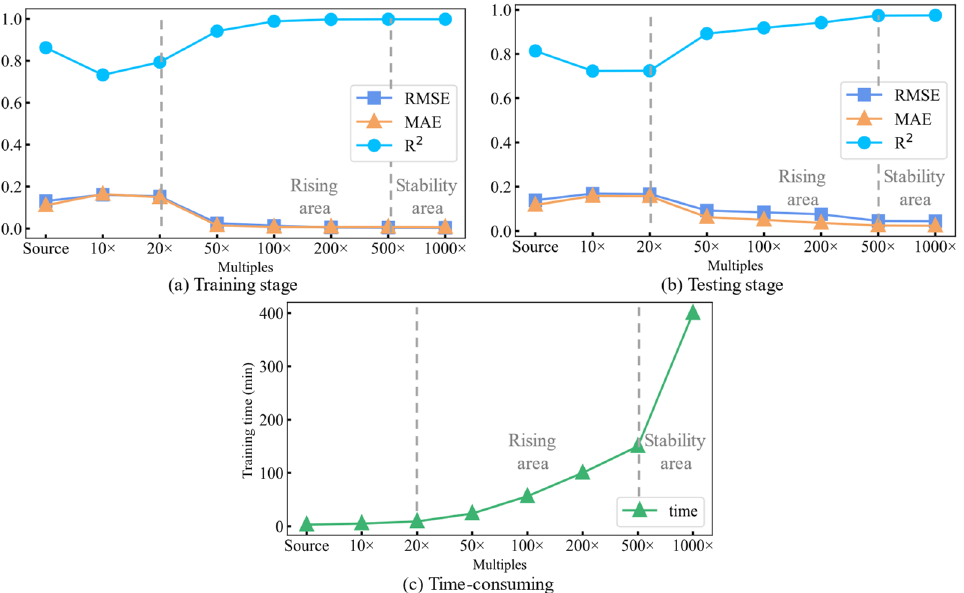
Figure 4. Comparison of prediction accuracy and training time of models with different augmenta- tion multiples: ( a ) stage of training; ( b ) stage of testing; ( c) time-consuming. multiples: ( a ) stage of training; ( b ) stage of testing; ( c)